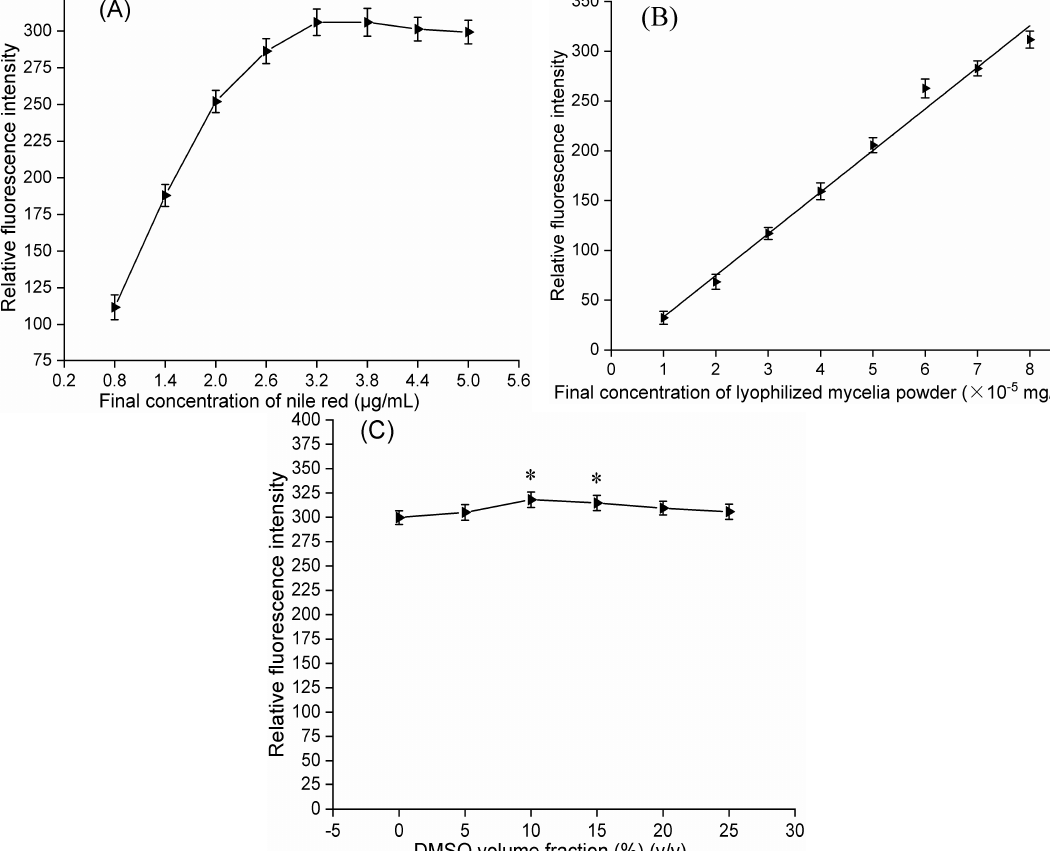
Figure 5. Optimizing conditions for determining the relative fluorescence intensity from mutant CM1-1-1. ( A ) Response of relative fluorescence intensity to different concentrations of Nile red. ( B ) Effect of different concentrations of lyophilized mycelium powder on fluorescence intensity. ( C ) Effect of pretreatment with different volume fractions of DMSO on relative fluorescence intensity. The asterisks above data points indicate a significant difference from the control (LSD, p <